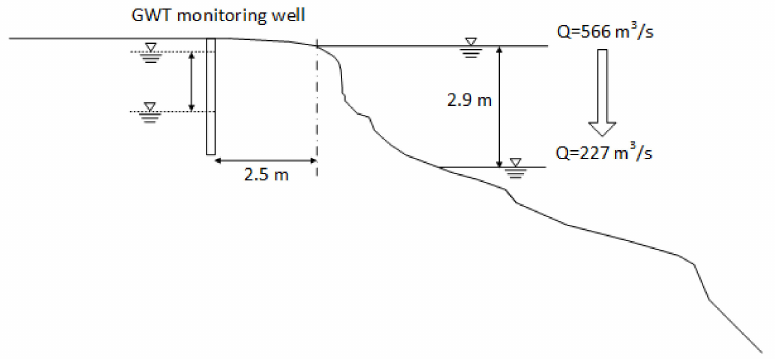
Figure 5. Schematic of the groundwater table observation hole at site 1 with the change in WSE shown for an example drawdown